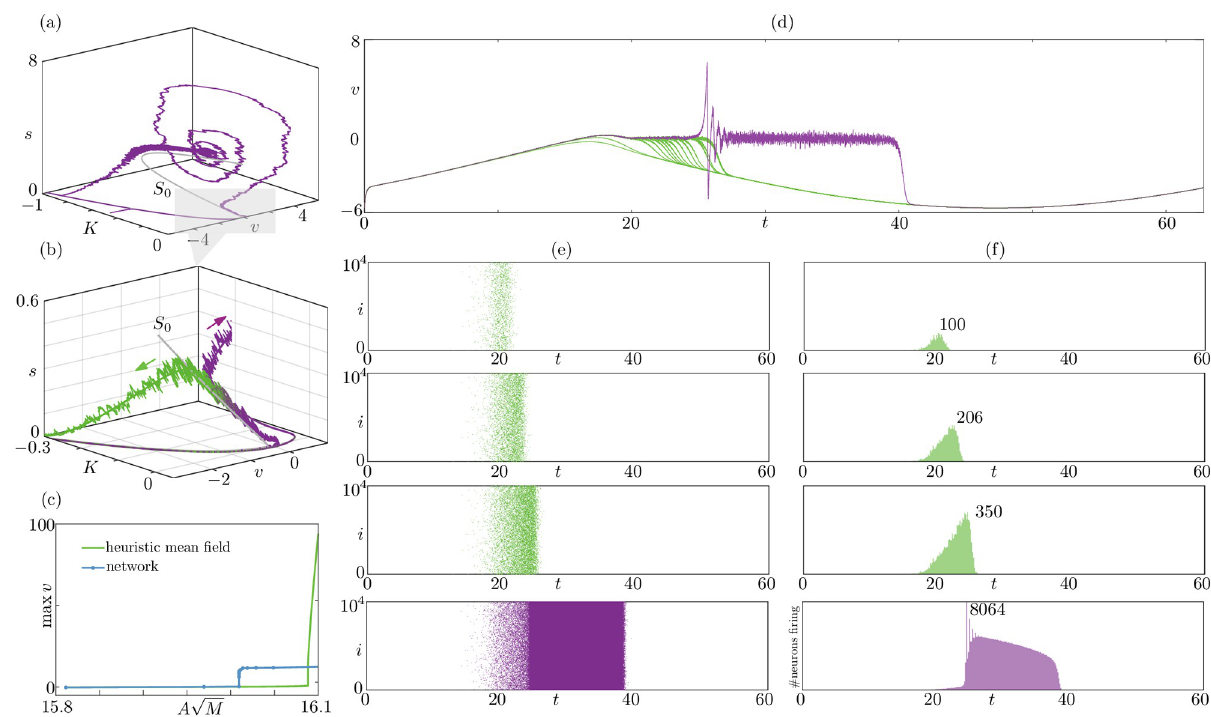
Fig 7. Dynamics of the sparse network (16) with randomly-distributed currents and randomly-distributed connectivity. Panel (a) shows a network bursting solution plotted in the 3D phase space ( K , v , r ) together with the critical manifold S 0 of the heuristic mean-field system (17). A down-up canard segment is visible in the greyed out region. (b): A zoomed view of panel (a); in addition to S 0 and the bursting solution of panel (a) in purple ffiffiffiffiffi p ( A ¼ 16 : 009453593274596 = ), we show an orbit with down-down canard segment obtained for slightly perturbed values of A , in green M ffiffiffiffiffi p ( A ¼ 16 : 009453593274599 ); we also superimpose solutions of the heuristic mean-field system, whose curves do not have fluctuations, unlike the M network ones. Panels (a,b) constitute numerical evidence that a down-to-up canard-mediated transition to bursting exists in this network, as further shown in panels (c–f). (c): Down-to-up route to bursting in the network (blue) and heuristic mean field (green); besides some discrepancies discussed in the main text, both branches contain a quasi-vertical segment typical of canard dynamics, bridging between the non-bursting regime and the bursting one. (d) Representative network solutions along the vertical branch in panel (d), between A ¼ 15 : 8113883008419 = ffiffiffiffiffi p , displayed in the time series for the voltage v ; this solutions reveal a clear down-to-up transition, from non bursting A ¼ 16 : 0094535932746 = M (green) to bursting (purple) orbits possessing canard segments (near v = 0); the peculiarity of these sparse-network canard solutions is that the associated rate increases rapidly in the canard regime while the mean voltage remains approximately constant, as evidenced in panels (e,f). (e): raster diagram of selected down-to-down (green) and down-to-up (purple) network solutions from (d); the canard segments manifests themselves in the raster plots: their onset coincides with the onset of spiking, and their termination with the jump to the quiescent phase (green) or the start of the tonic phase (purple); along the segment, the network builds up rate (as shown in (f)). (f): histograms of firing events between t and t + Δ t , with Δ t = 0.15; along the canard segments the solution increases the firing rate (the longer the segment, the higher the maximum rate in the green histograms); the purple diagram is at a different scale with respect to the green ones, and it represents a bursting solution. Parameters: N = 10 4 , M = 10 3 , J = 1, τ Δ γ = 0.3, ε = 0.1, � Z ¼ (cid:0) 0 : 5 , Δ = 10 − 4 , v t = − v r =